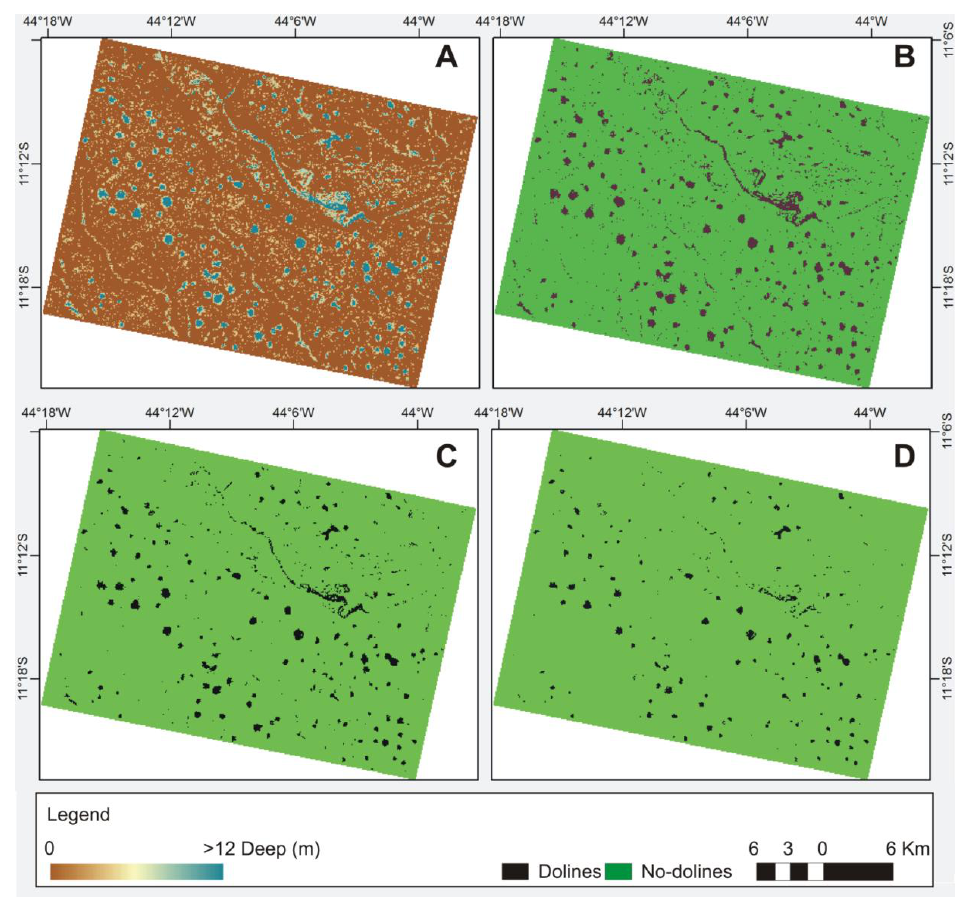
Figure 7. Depth image from ( A ) SRTM-DEM and binary mask images made with sink-depth thresholds of ( B ) 1 m, ( C ) 2 m and ( D ) 3 m.